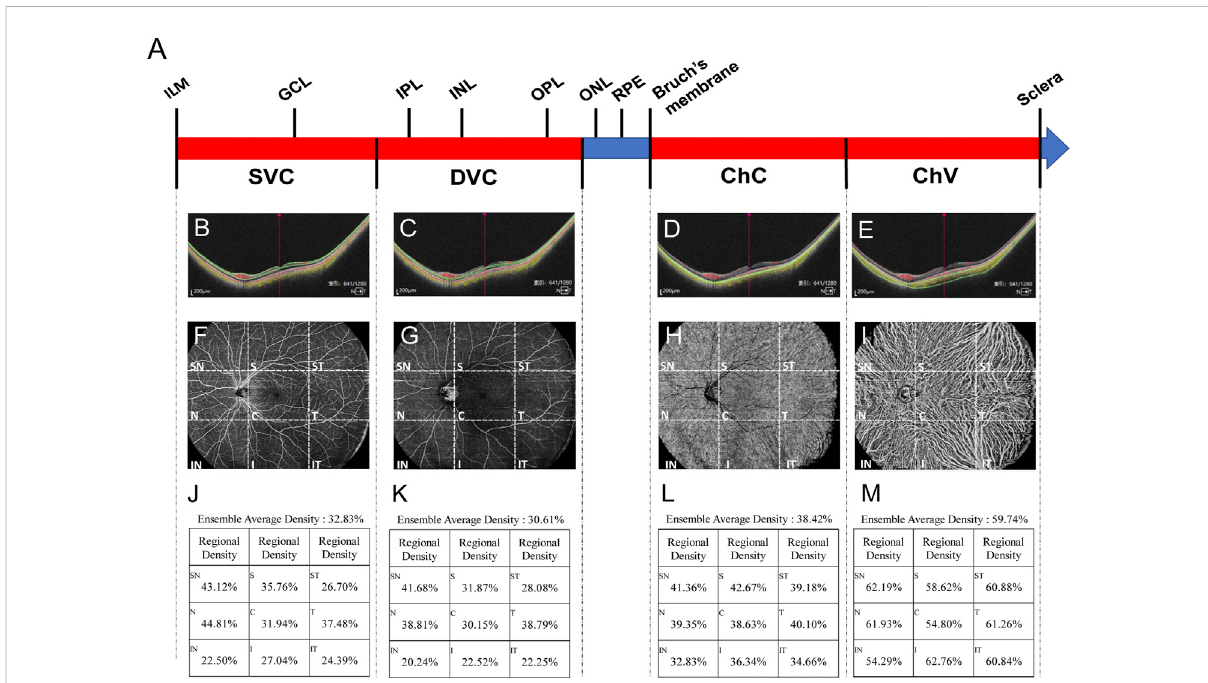
FIGURE 1 Each cross-sectional image obtained through OCTA scanning was automatically sectioned by the built-in software into four vessel layers, namely, SVC,DVC, ChC,and ChV (A) .In therepresentative image, thefovea isatthecenter(long redarrow),towhichontheleftis thenasal sideand therightisthetemporalside.GreenlinesindicatetheboundariesofSVC (B) ,DVC (C) ,ChC (D) ,andChV (E) .Reddotsrepresenttheblood fl owsignals of the retina and choroidal capillary; yellow dots stand for those of choroidal vessels (B – E) . Both red and yellow signals were obtained through processing the scanning data with complicated algorithms. The representative of the scanned images at the enface interface is also shown with (F) (G)(H) , and (I) corresponding to SVC, DVC, ChC, and ChV vessel layers, respectively. Each image is divided by the built-in software into nine regions, namely,ST,S,SN,T,C,N,IT,I,andINregions.Vesseldensityofeachregionateachvessellayerisquanti fi ed (J – M) .SVC,super fi cialvascularcomplex; DVC, deep vascular complex; ChC, choriocapillary layer; ChV, choroidal vessel layer; ST, supratemporal; S, superior; SN, supranasal; T, temporal; C, central macular; N, nasal; IT, inferotemporal; I, inferior; and IN,